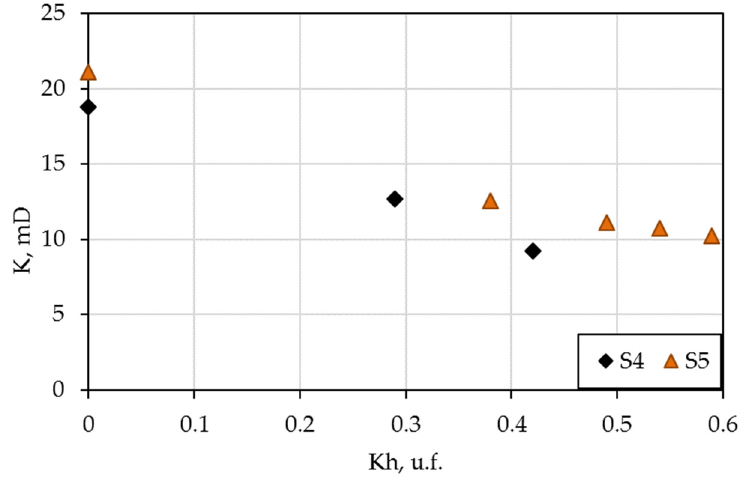
Figure 4. E ff ective gas permeability vs. hydrate coe ffi cient for methane hydrate at − 5 °C.